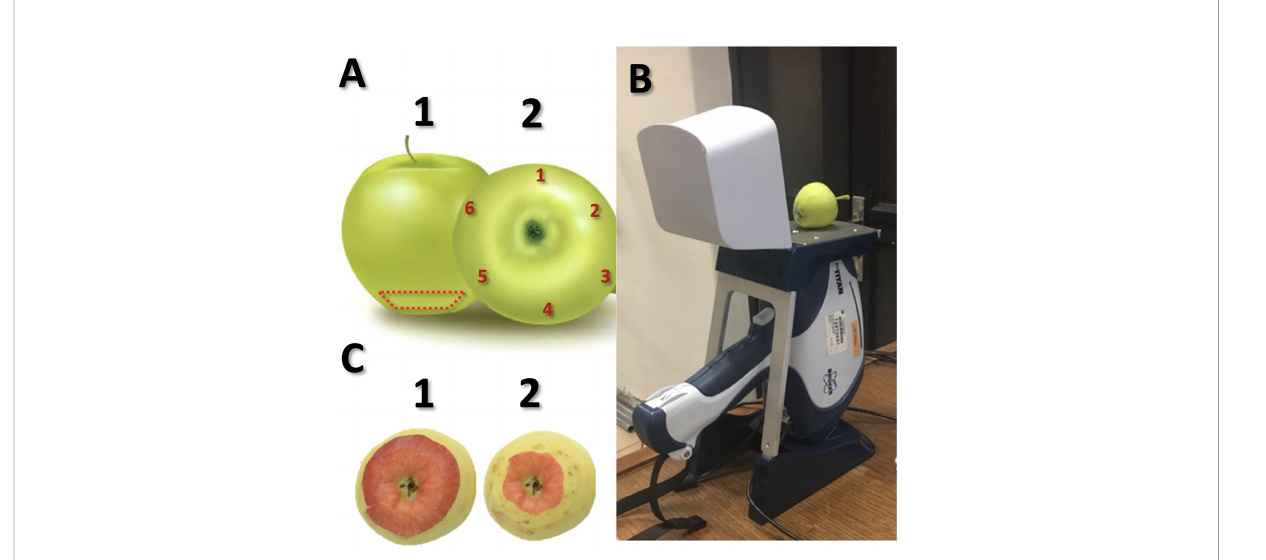
FIGURE 1 Section of the fruit calyx (dashed red line) where the bitter pit is usually located (A-1) and where the reproducibility XRF study was performed at six equidistant points (A-2) ; details of XRF measurement (B) ; bitter pit in fruit with no external symptoms, before (C-1) and after fruit peeling (C-2)